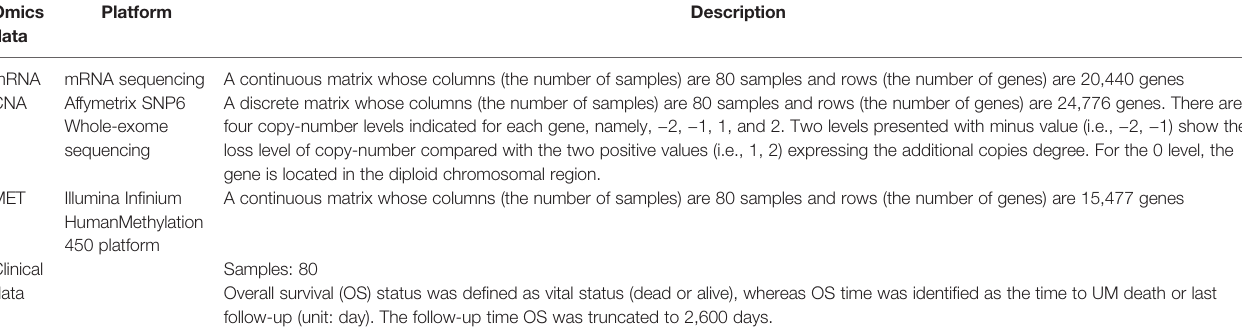
TABLE 1 | Description of a cohort of UM patients used in the study.